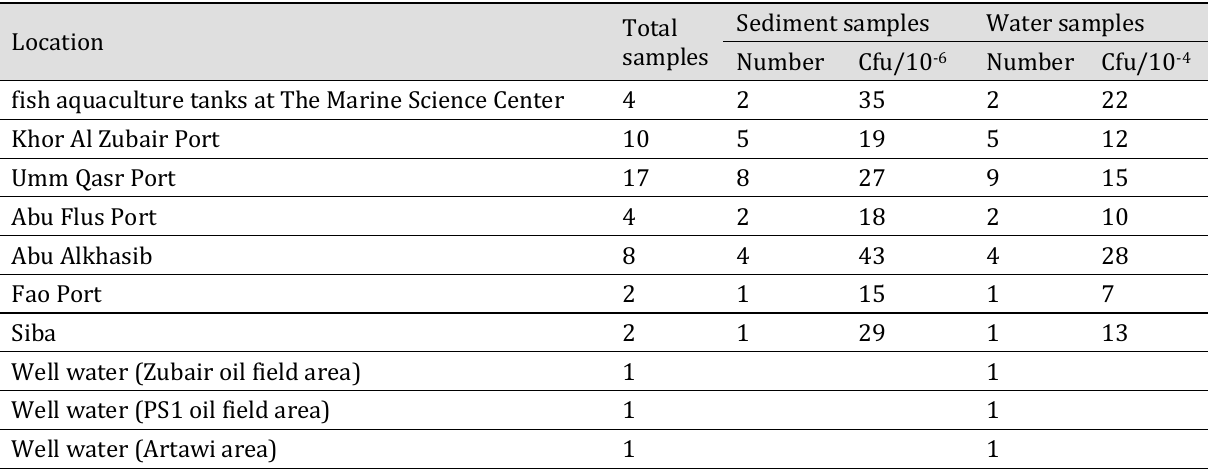
(Colonies numbers